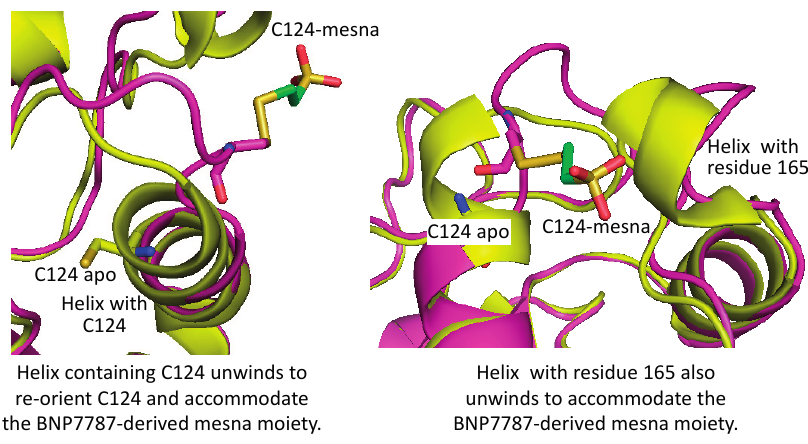
Figure 6. Ribbon diagrams of the Prx 4 crystal structure and the BNP7787-derived modifications of Prx 4. ( A ) Apo-Prx 4 structure showing multimer interface. The C-terminal tail (green) of molecule A (yellow) wraps around molecule B (pink) such that Cys 124 (C124) of molecule B is in close proximity to Cys 245 (C245) of molecule A; ( B ) Crystal structure of BNP7787-derived mesna adduct on Prx 4 showing BNP7787-derived mesna binding at Cys 124 and the C-terminal tail of molecule A ending at residue 242; ( C ) Overlay of the apo Prx 4 (Figure 6A) and the Prx 4 co-crystal containing a BNP7787-derived mesna (Figure 6B) structures showing a steric clash between the C-terminal tail of molecule A (apo, green/pink) and the BNP7787-derived mesna bound to molecule B (orange). ( D ) Close-up of BNP7787-derived mesna binding site showing partial unwinding of helix containing Cys 124 and unwinding of helix containing residue 165 to accommodate the BNP7787-derived mesna moiety at Cys 124 (apo Prx 4 is shown in yellow and the Prx 4-BNP7787 co-crystal is shown in